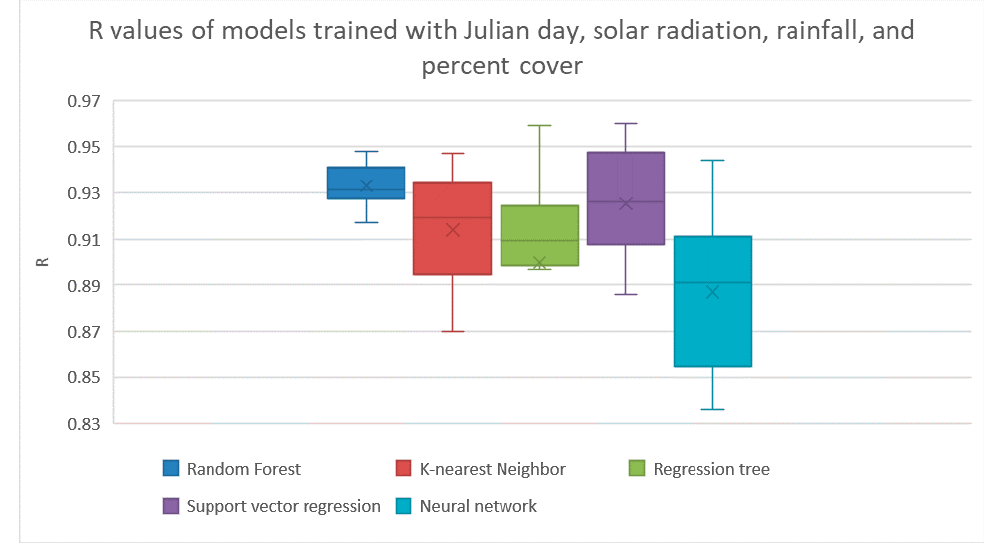
Figure 3. Results from Cfs feature selection with all features. The results from linear regression and Bayesian ridge regression were much lower than the other models, so their results are not shown here. The results are shown explicitly in Table 4.